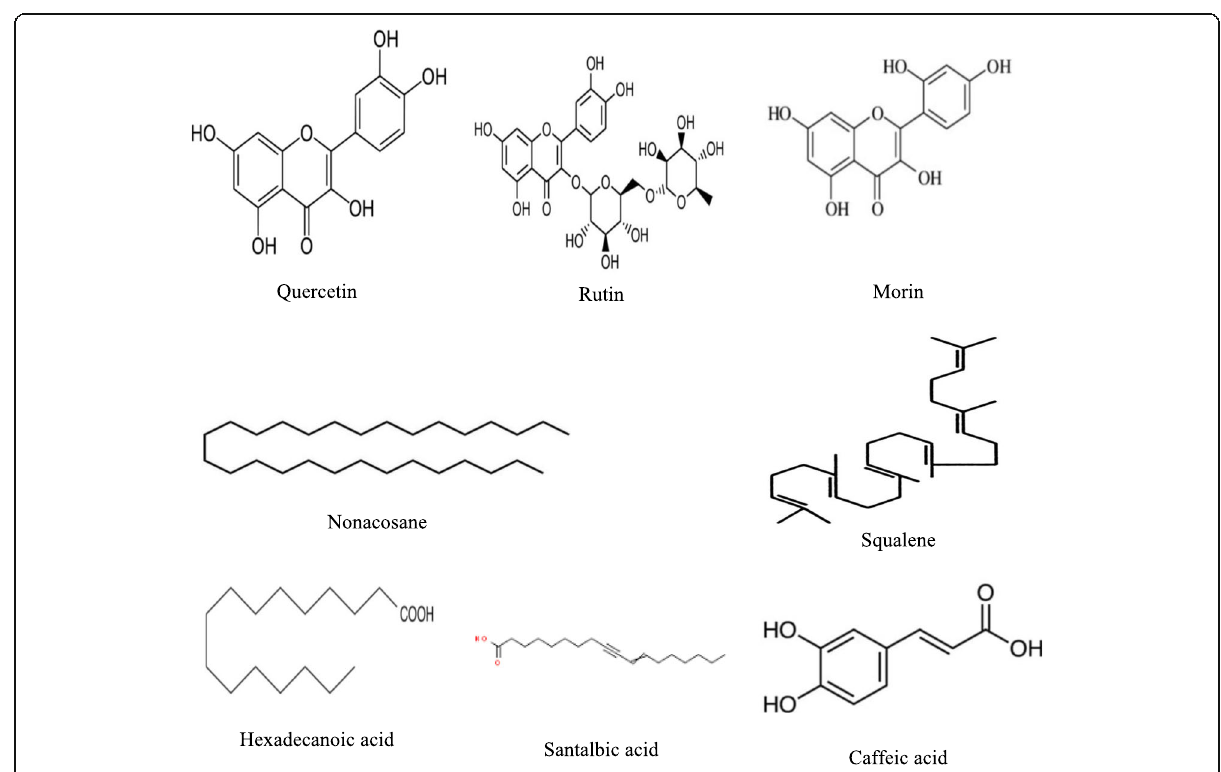
Fig. 2 Chemical structures of isolated compounds from